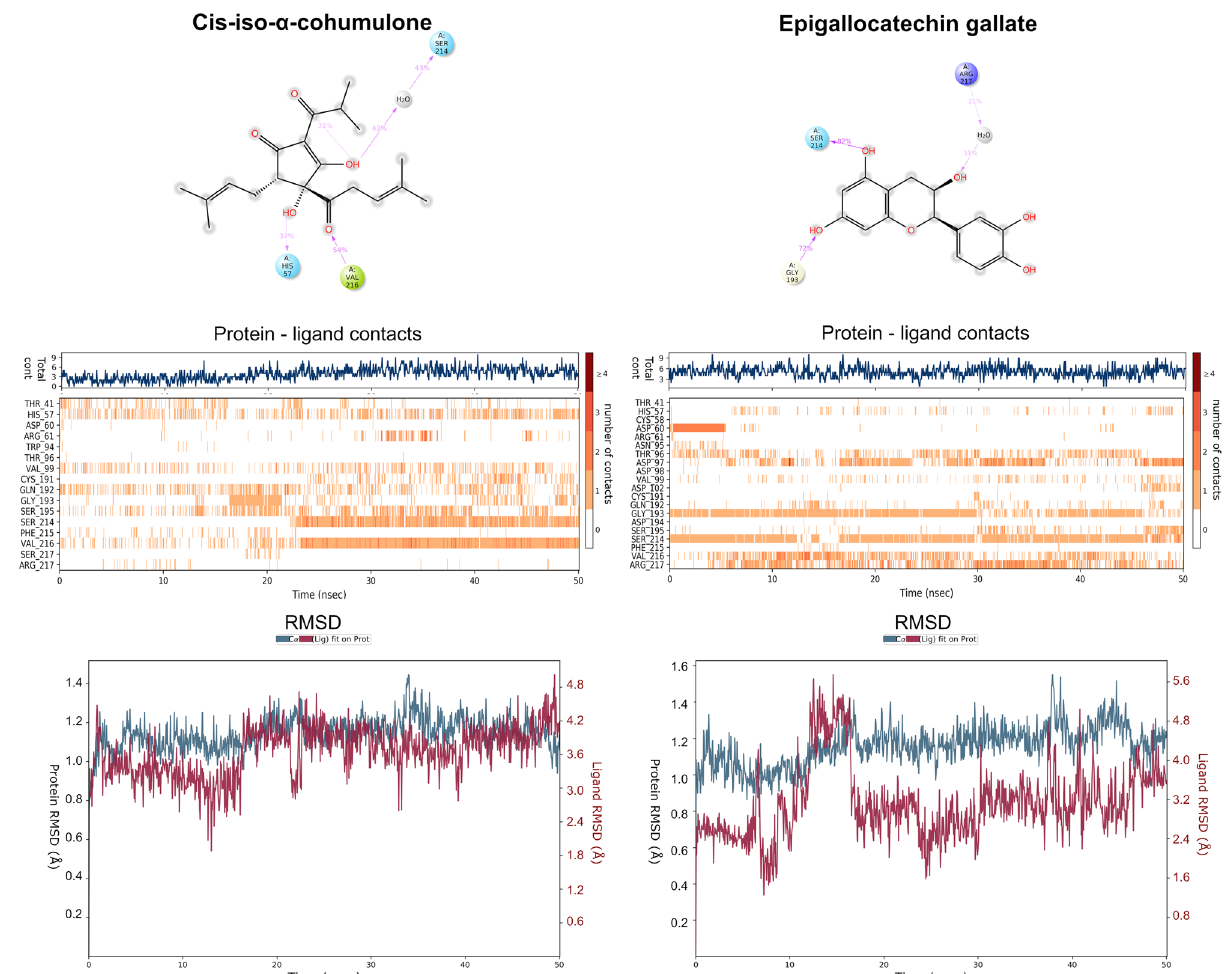
Figure 2. Molecular dynamics analysis of cis-iso-α-cohumulone and the standard elastase inhibitor epigallocatechin gallate. Final docking position, protein–ligand contacts, and RMSD values are